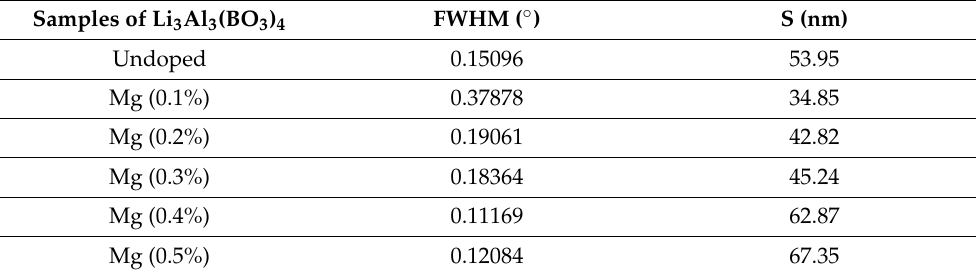
Table 1. The crystallite sizes for the samples of doped and undoped lithium aluminium borate.